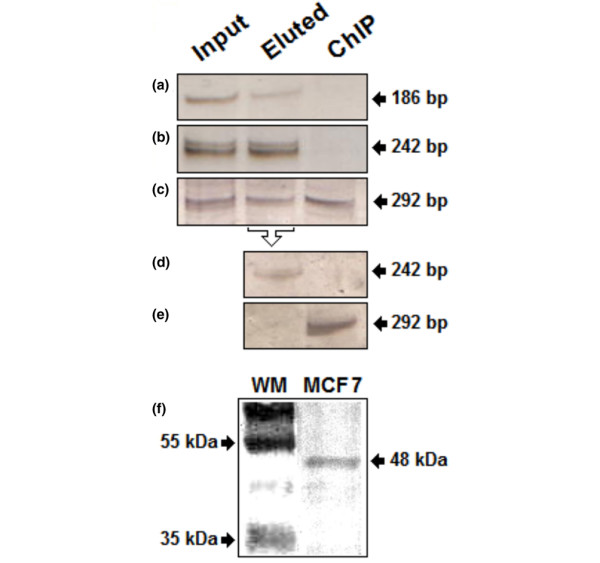
Chromatin immunoprecipitation assay of GATA3 in MCF7 breast cancer cells. Chromatin complexes were crosslinked in vivo with formaldehyde (see the Materials and methods section). The GATA3-associated DNA fragments were immunoprecipitated (IP) with mouse monoclonal antibody against GATA3 (HG3-31). DNA samples were isolated before IP (lane labeled 'input'), after elution the unbound proteins from the Protein A–Sepharose batch (lane labeled 'eluted') and after specific IP (lane labeled 'ChIP', for chromatin immunoprecipitation). (a–c) PCR was performed with (a) flanking primers amplifying a GATA1 binding site on the MUC1 promoter (186 bp; see Figure 2), (b) flanking primers for amplification of exonic sequences of the HLA-DQA1 gene (242 bp; negative control), and (c) flanking primers for amplification of the GATA3-binding site on the MUC1 promoter (292 bp) as shown in Figure 2. (d–e) Second ChIP (reChIP) assay using the first eluted DNA–protein complex as input sample. (f) Western blot analysis of GATA3 protein expression: a sample of MCF7 protein extract was run on a 10% SDS-PAGE gel and assayed for GATA3 expression with the monoclonal antibody used in ChIP assays (HG3-31). The expected wild-type band of 48 kDa was immunodetected. Lane WM shows an SDS-7B prestained SDS-molecular mass standard (Sigma-Aldrich).